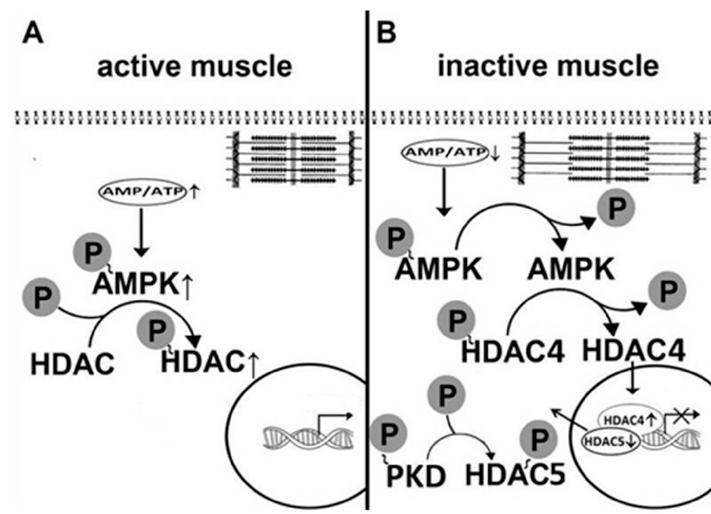
Figure 3. The role of AMPK in class IIa histone deacetylases traffic in rat soleus muscle at the initial stages of gravitational unloading (modified from [98]). ( A ): active muscle; ( B ): inactive muscle. Time-course studies on the MyHCI ( β ) expression demonstrate that a reduction in MyHCI ( β ) mRNA expression begins on the first day of unloading and then steadily decreases during, at least, two weeks of hindlimb unloading [13,14]. As shown in dominant-negative AMPK mutants, AMPK has no effect on the expression of slow MyHC after 14-day unloading [63]. It is clear that an experiment with transgenic animals does not allow for tracing the effect of AMPK on the expression of MyHC at the different time-points of unloading. However, the results of this experiment indicate that the decrease in the expression of slow isoform of MyHC after the completion of the initial stage of hindlimb unloading is determined not by AMPK, but by some other mechanisms, for example, via inhibition of the calcineurin/ Nuclear factor of activated T-cells (NFAT) signaling pathway